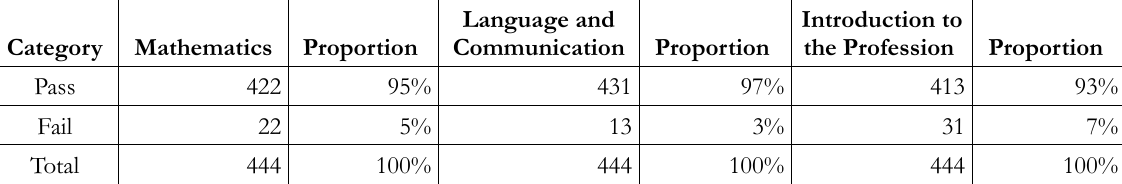
Table 2. Pass and fail